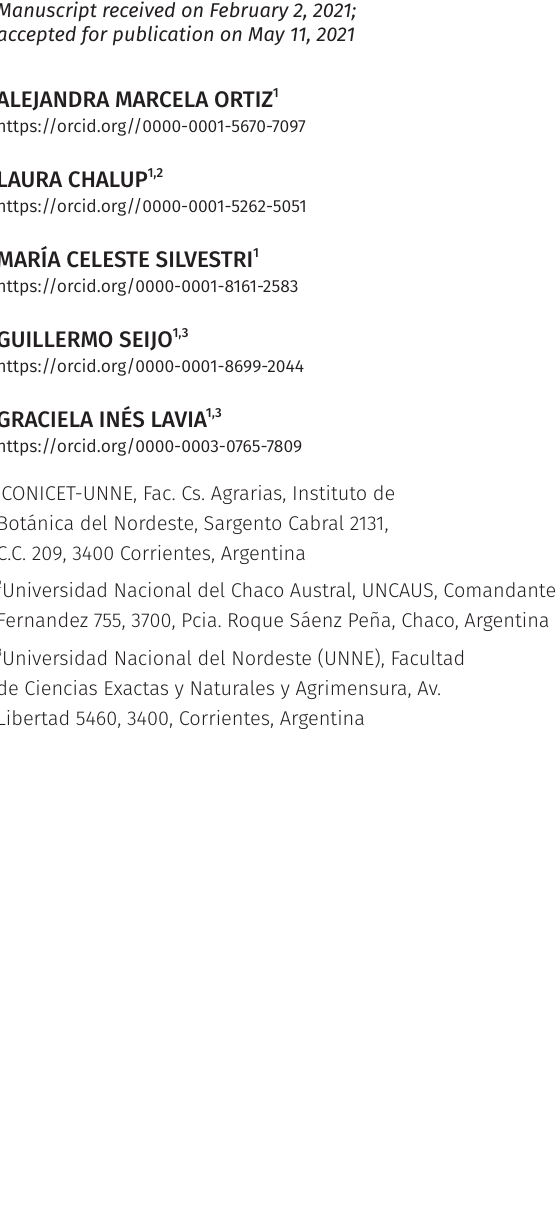
How to cite ORTIZ AM, CHALUP L, SILVESTRI MC, SEIJO G & LAVIA GI. 2023. Genomic relationships of the polyploid rhizoma peanut ( Arachis glabrata Benth.) inferred by genomic in situ hybridization (GISH). An Acad Bras Cienc 95: e20210162. DOI